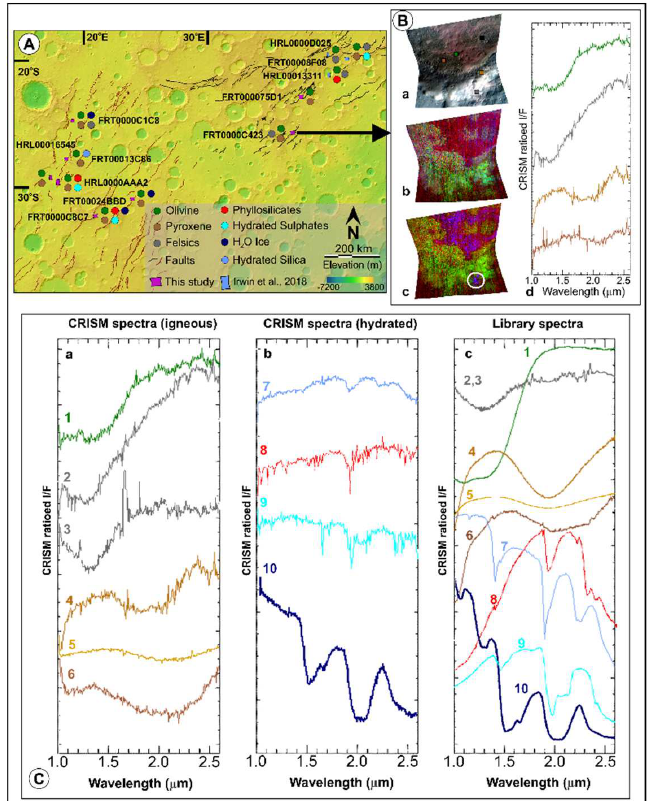
Figure 6. CRISM analysis and minerals detected in the study area. ( A ) Location map. WH and NWH structures are traced in red and black. Colored dots represent specific minerals from each observation. ( B ) A sample presentation of the CRISM analysis from FRT0000C423. ( a ) False color composite with four regions of interest marked by four colored squares which correspond to the colors of the adjacent spectra. The black square represents the location of the neutral spectra used to produce the presented ratioed spectra. ( b ) RGB composite with summary parameters highlighting olivine (red) and pyroxene (green) [R = OLINDEX3 (0.000–0.173), G = LCPINDEX2 (0.000–0.024), B = HCPINDEX2 (0.000–0.027)]. ( c ) RGB composite with summary parameters highlighting olivine (red), pyroxene (green), and plagioclase (blue, outlined by white circle) [R = OLINDEX3 (0.000–0.187), G = LCPINDEX2 (0.000–0.025), B = BD1300 (0.000–0.017)]. ( d ) CRISM-ratioed spectra showing from top to bottom: olivine (green), plagioclase (grey), LCP (light brown), and HCP (dark brown). ( C ) Sample spectra from CRISM observations FRT0000C423, FRT0000C1C8, FRT00013C86, HRL0000AAA2, and FRT0000C8C7. CRISM-ratioed spectra numbered 1–10 and color-coded to match the dot colors used